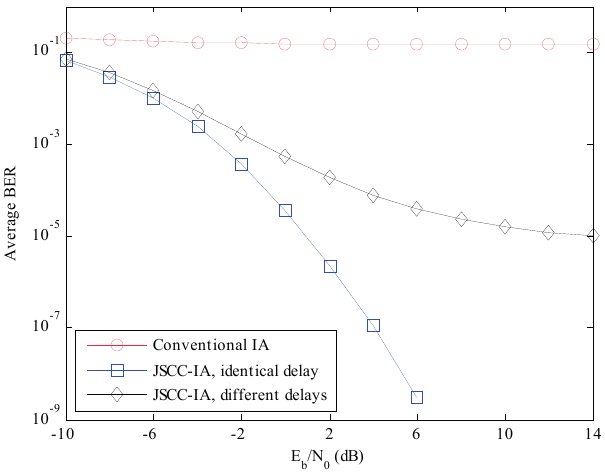
Figure 6. The average experimental BER performances of the conventional IA scheme and the JSCC-IA schemes with identical/different propagation delays in the (6 × 6, 2) 18 symmetric